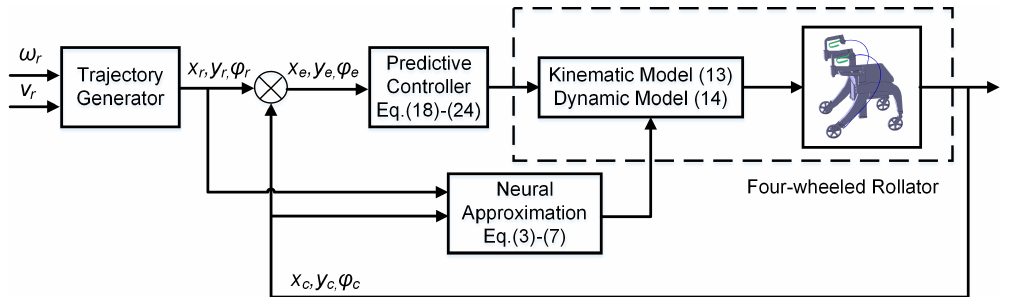
Figure 11. Controller framework of